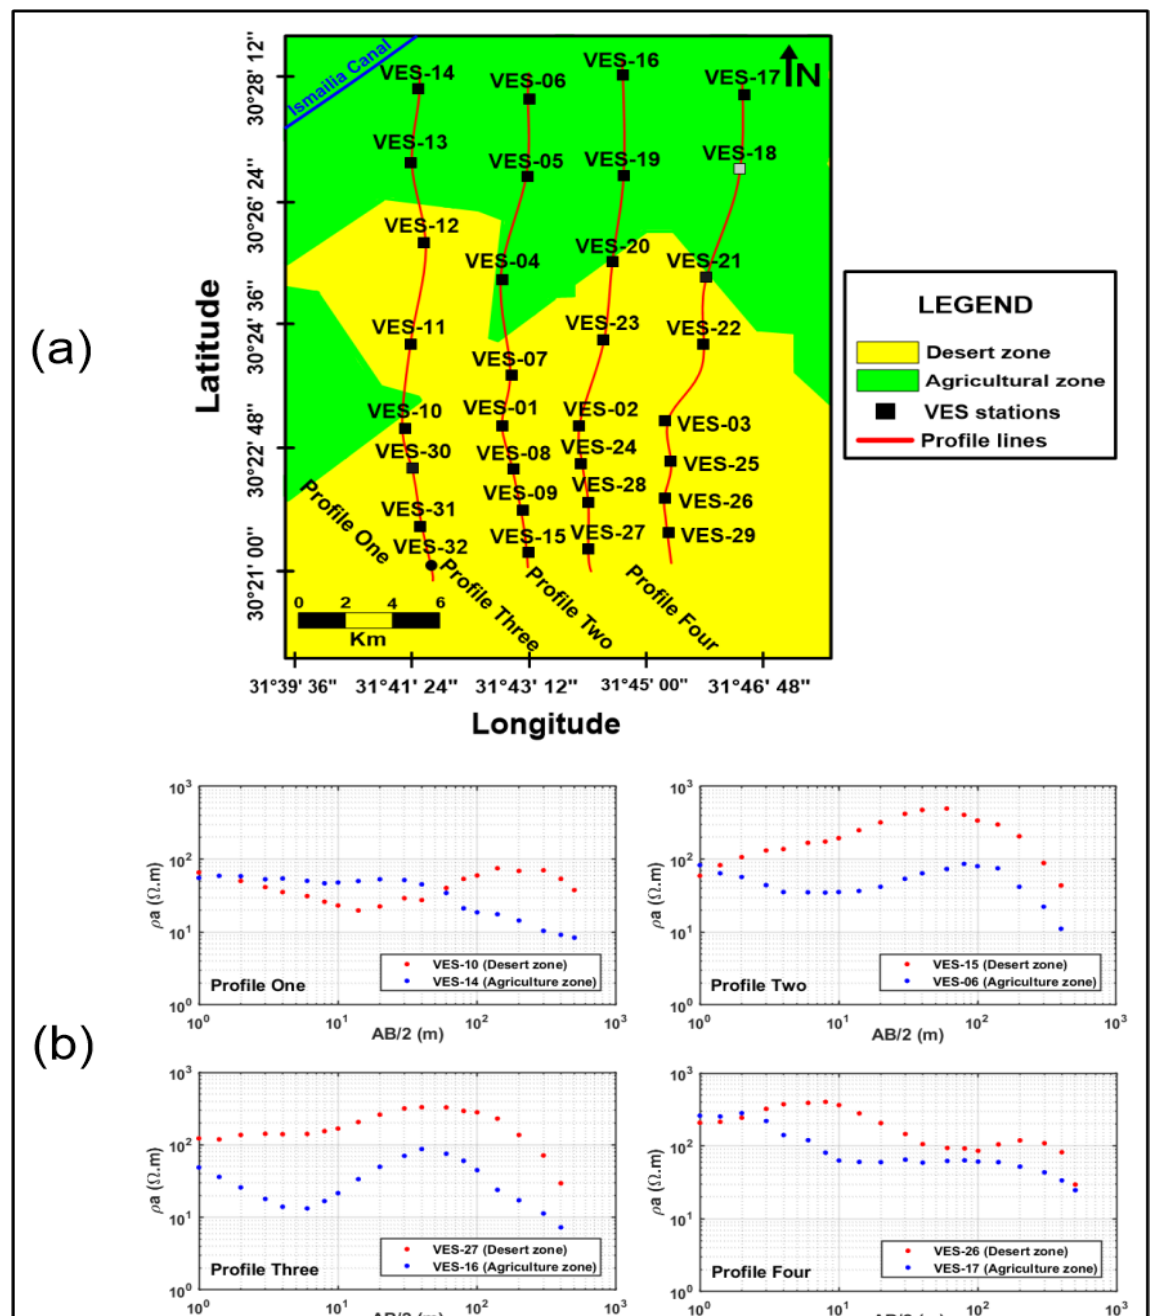
Figure 3. ( a ) Location map of VES sites on the agriculture zone in the north half of the study area and on the desert zone in the southern half of the study area, and ( b ) apparent resistivity as function of electrode distances (AB/2) of some selected VES data along four main profiles on the agriculture zone and on the desert zone. Table 1. Example of raw electrical resistivity (DC) data (apparent resistivity and AB/2) at some se- lected VES stations along the main profiles.